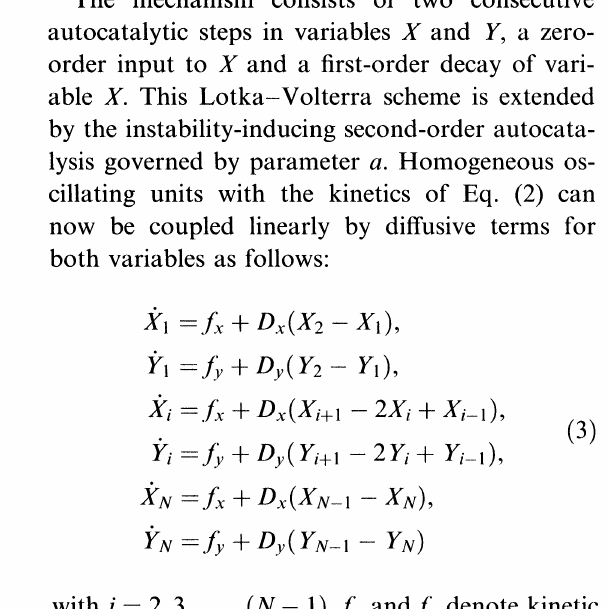
D. Figure 2 is a